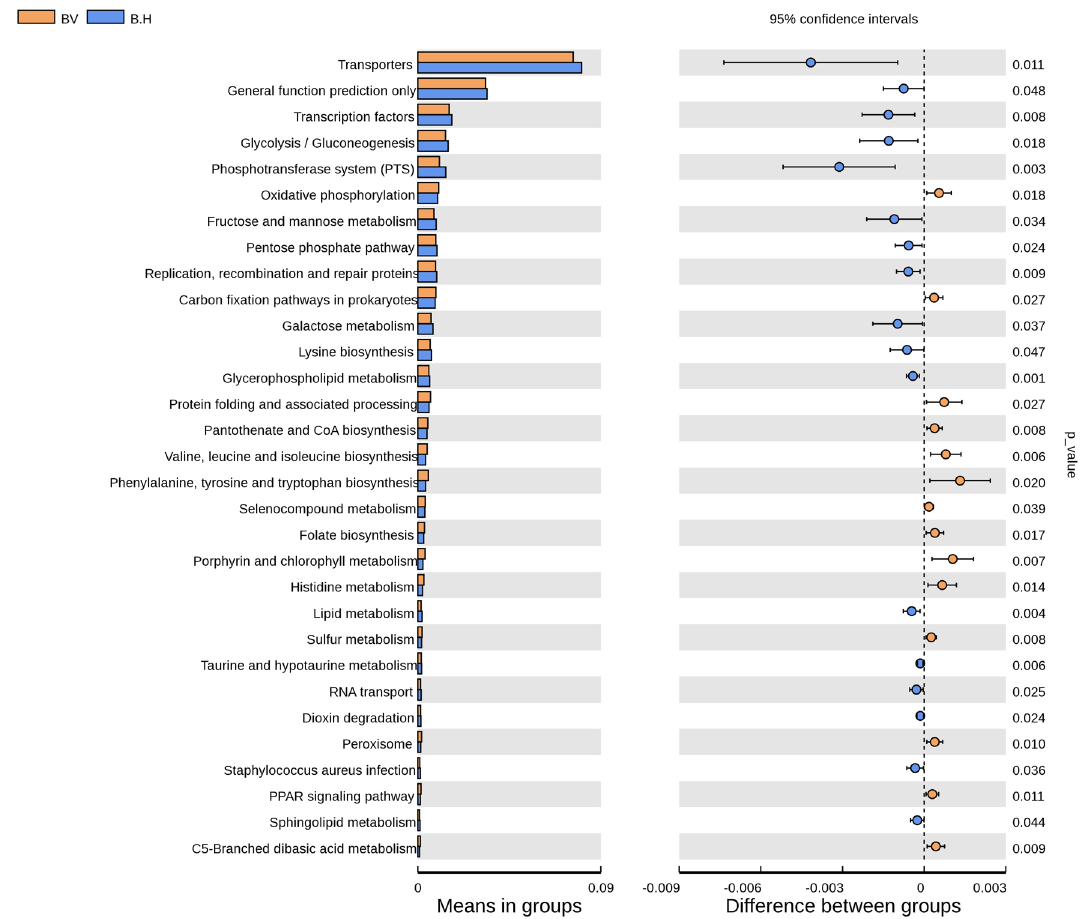
Figure 6. Predicted bacterial function pathways differences between BV and BV + HPV co-infected women. PICRUSt algorithm was used to predict bacterial gene functions from the KEGG annotated databases 22–24 . The bar chart on the left represents the percentage of the abundance of a certain metabolic pathway from all metabolic pathways in the two groups of samples. Corrected P values are on the right side. T-test (two-tailed) was used to calculate the P- value. P value less than 0.05 was considered statistically